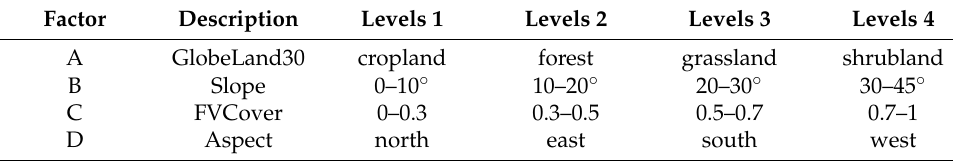
Table 2. Factors and Levels of Taguchi’s Experimental used in this